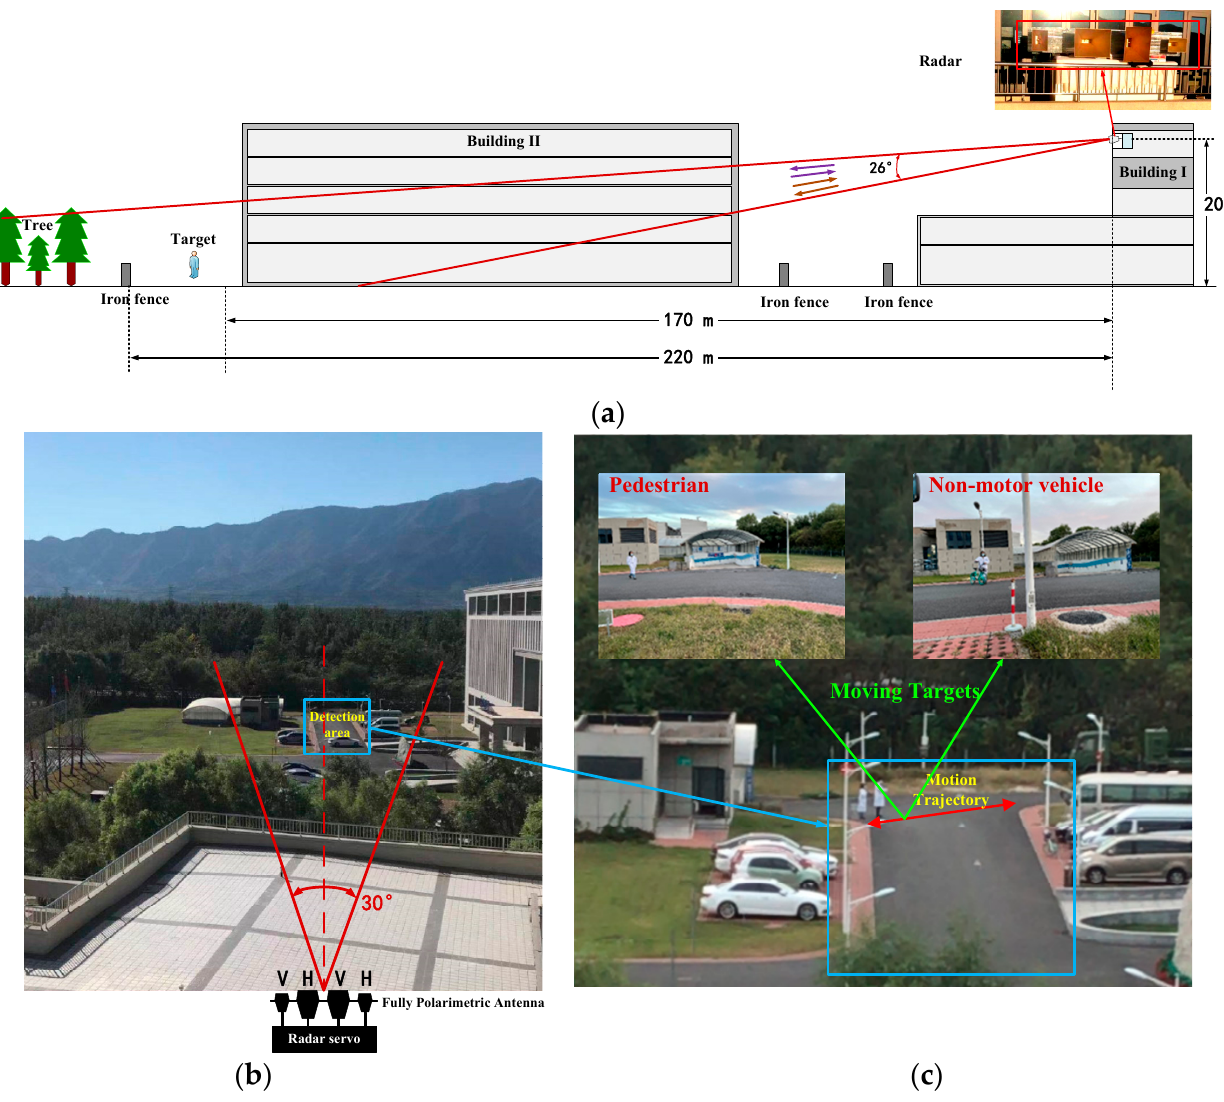
Figure 8. Experimental scene. ( a ) The diagram of detection scene. ( b ) The real detection scenarios. ( c ) The area of the target movement.